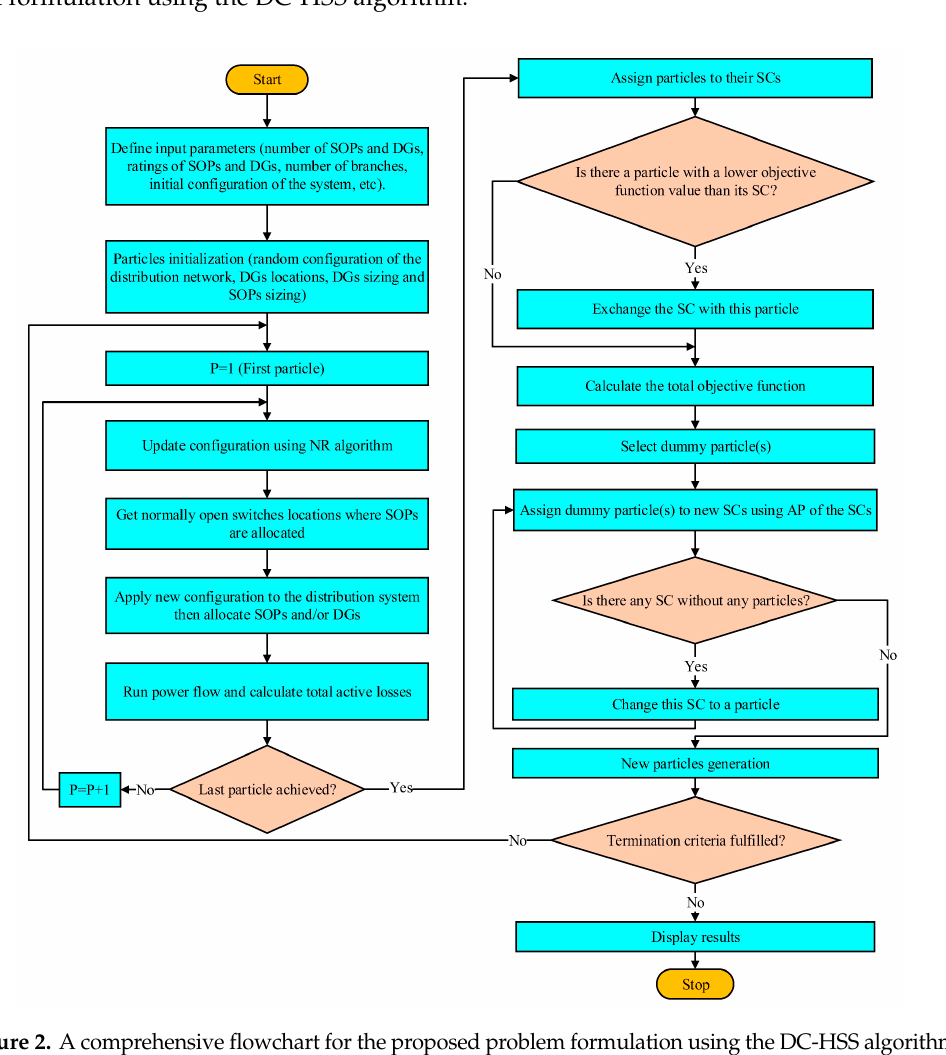
Figure 3. IEEE 33-node distribution system.